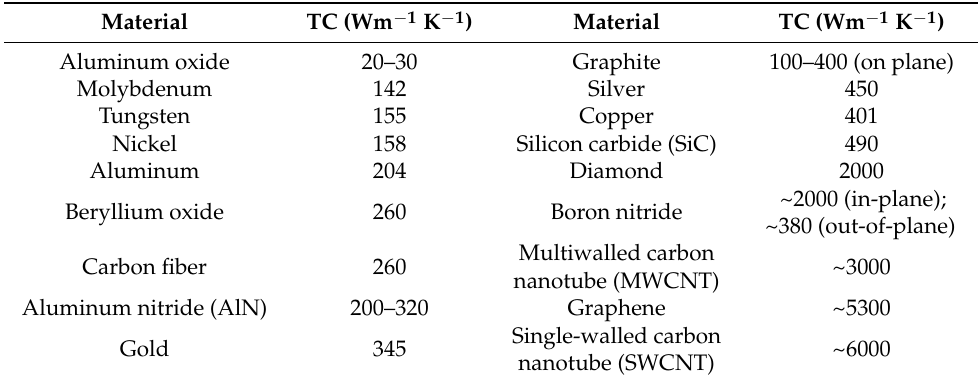
Table 1. Thermal conductivity (TC) of materials used as conductive fillers [36–40].